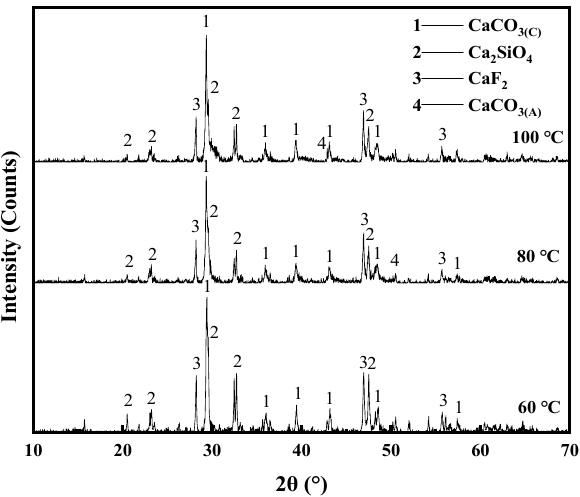
Figure 6. XRD pattern of the AOD stainless steel slag.